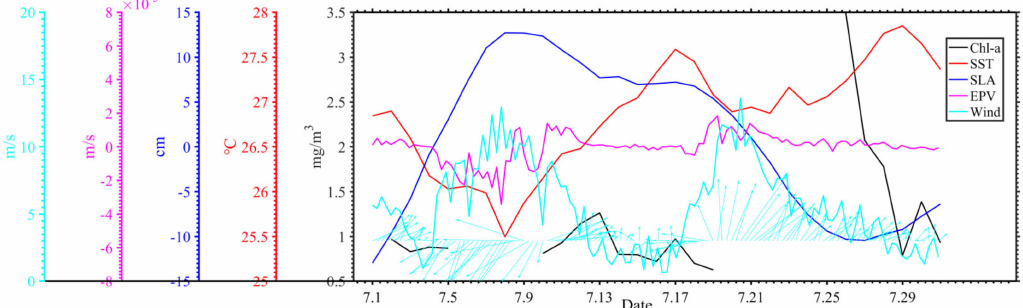
Figure 14. Time series of Chl- a concentration, sea surface temperature, sea level anomaly, Ekman pumping velocity, and wind speed (vector) in the coastal upwelling